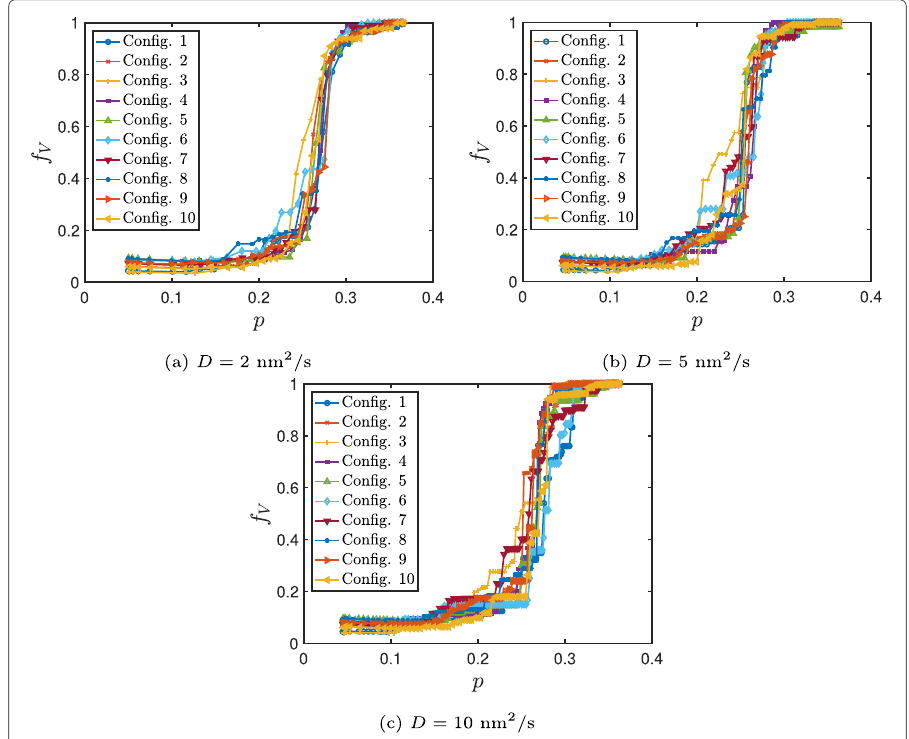
Fig. 7 Fraction of total bubble volume connected to a free surface, f V , as a function of porosity p for varying